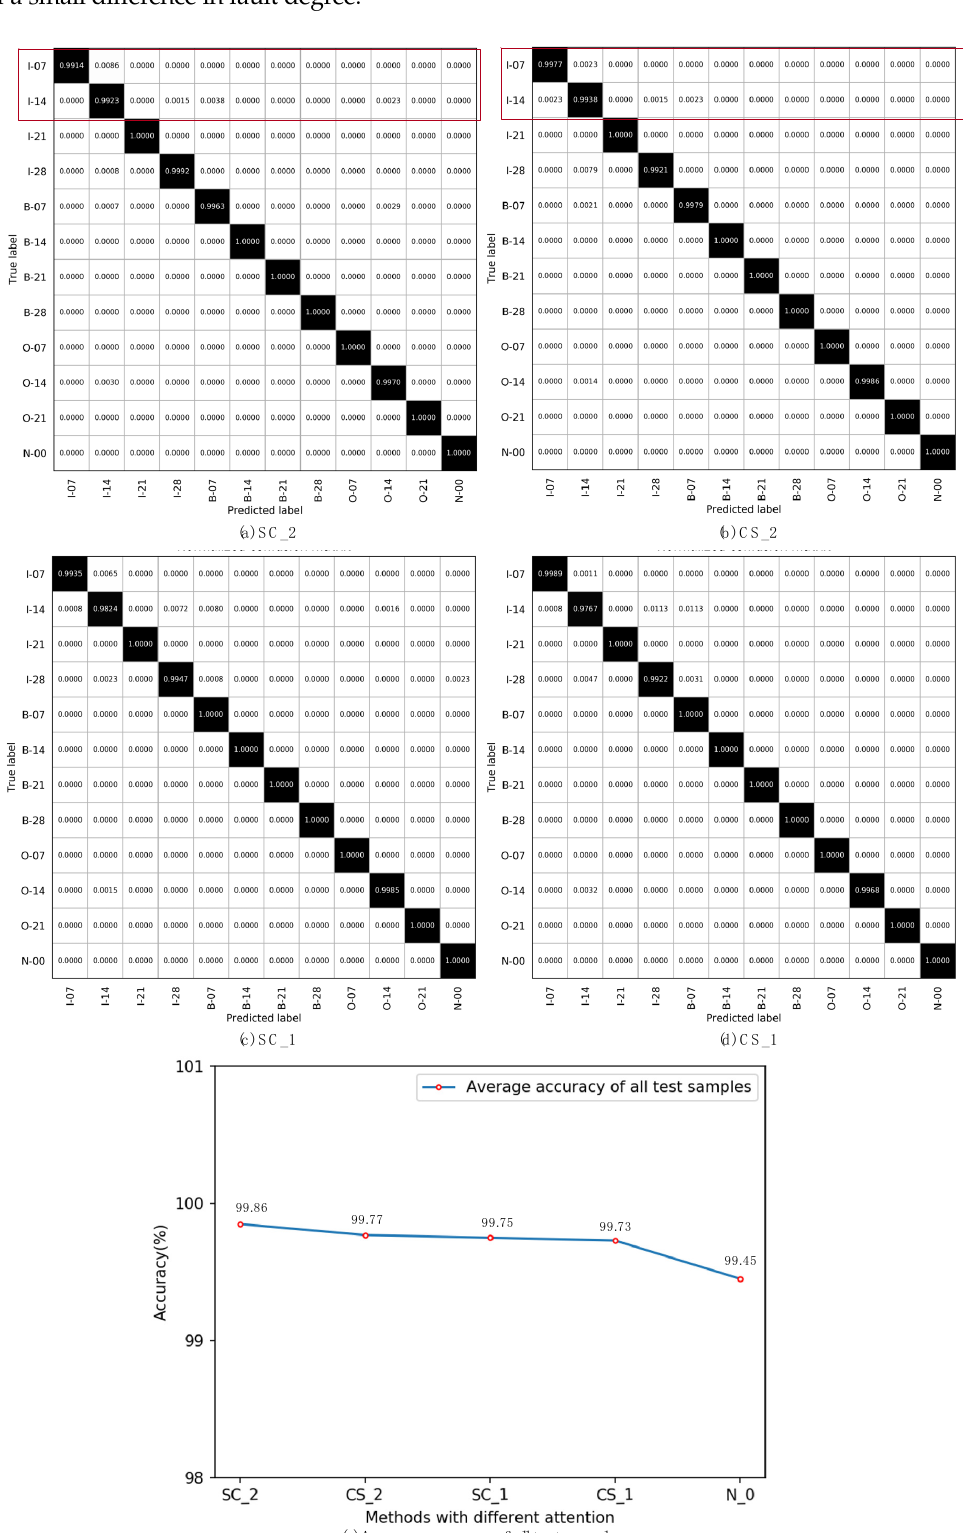
Figure 12. The results of fault identification using the proposed MA-MSCNN with di ff erent kinds of multi-attention